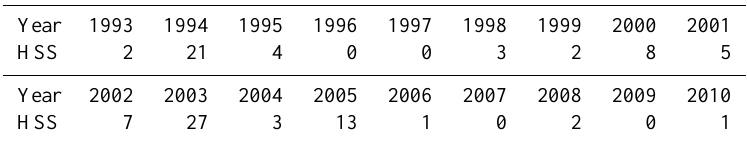
Fig. 3. Seasonal directional distributions of d H /dt exceeding 1nTs − 1 at the five stations in Table 1 during the solar cycles 22–23 (1986– 2009). Autumn and spring refer to about 90 days centred at equinoxes, and summer and winter are similarly centred at solstices. Table 2. Yearly number of high-speed streams (HSS) whose velocity exceeded 700kms − 1 and which lasted longer than 6h (extended from Tanskanen et al.,